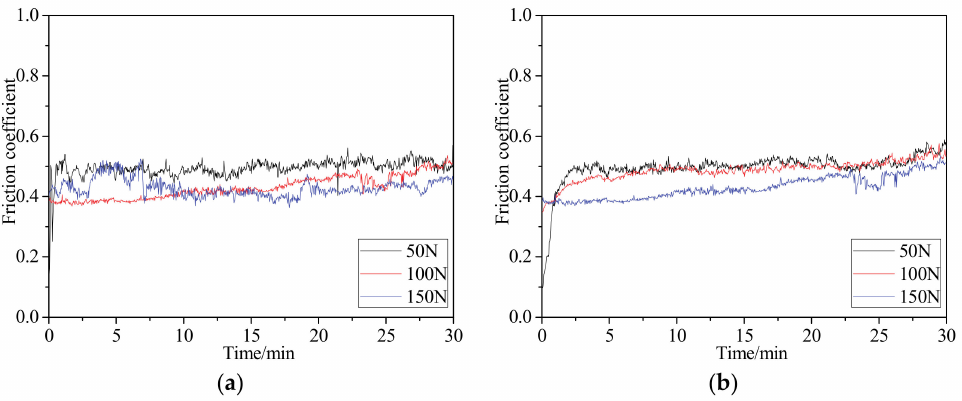
Figure 9. The friction coe ffi cient curves of untreated specimens and plasma-nitrided specimens under di ff erent loads: ( a ) untreated, ( b ) plasma-nitrided.